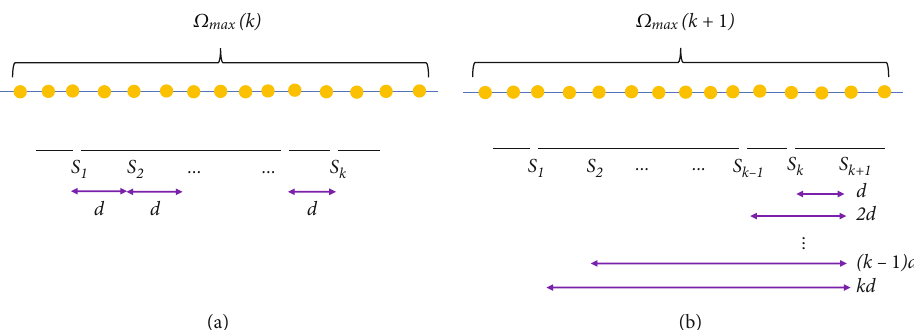
Figure 7: When the screen (blue line) is oriented parallel to the multiple slit barrier (black line), the total fringe count for ð k + 1 Þ slits (b) is equal to total fringe count for k slits (a) added to the counts for the pair-wise combinations of the S k +1th slit with each of the other slits f , S , S , ⋯ , S S 1 2 3 k g .